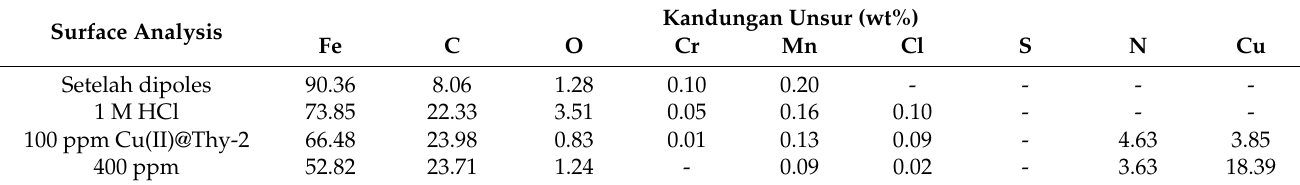
Table 4. Atomic mass percentage of each element in EDS